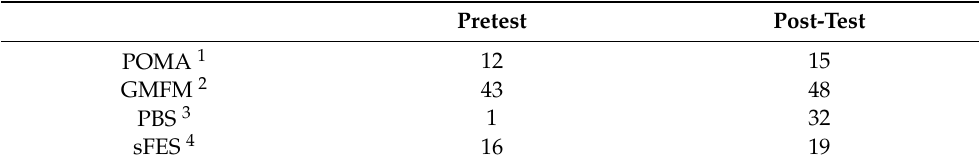
Table 2. Clinical outcome